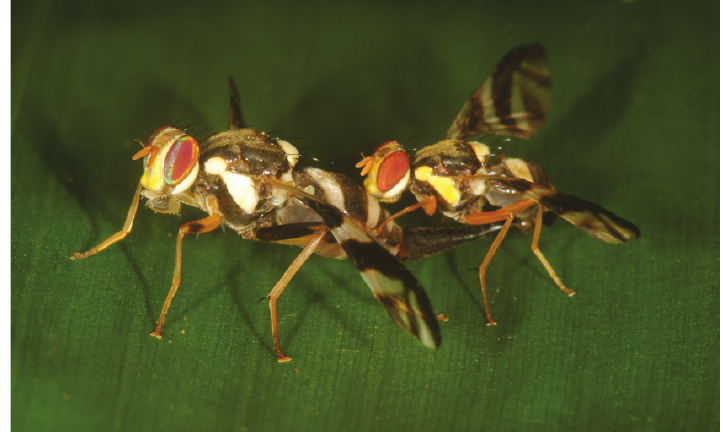
Figure 9. A. rufipes couple mating on the upper surface of a bamboo leaf. The forelegs of the smaller, yellowish male rest on the abdomen of the larger black and white